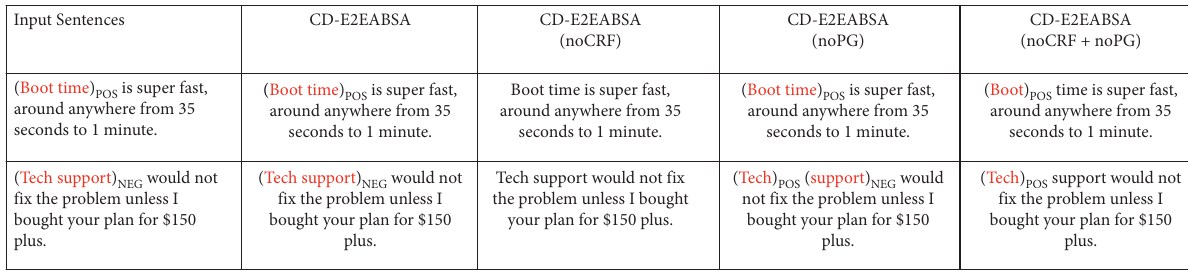
Figure 5: Performance of different models in the ABSA task.